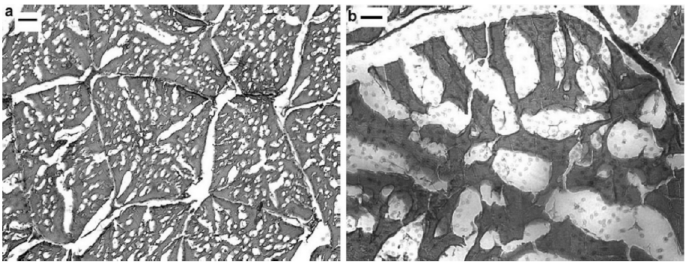
Figure 1. Micrographs representation of crab tissue frozen at different rates and local characteristic freezing times (tc); ( a ) tc = 11 min; bar represents 100 µ m; ( b ) tc = 29 min; bar represents 50 µ m. Reproduced from Dima et al. [83], with permission from Elsevier,